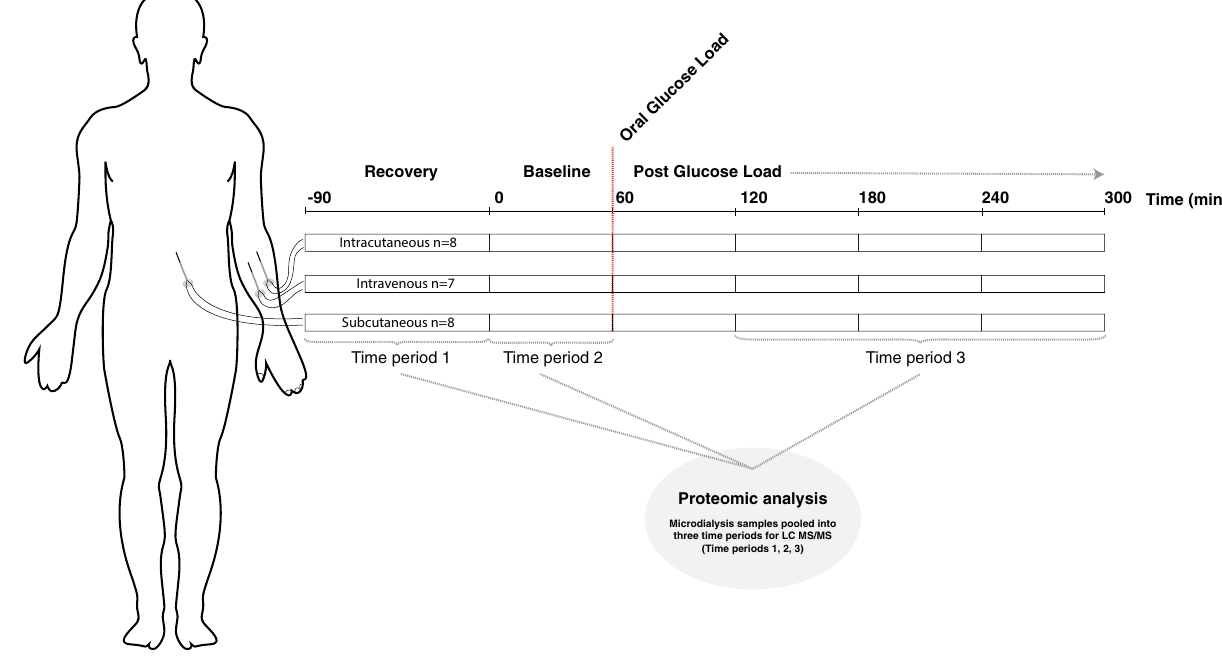
Figure 1. Experimental protocol and setup for in vivo microdialysis experiment in healthy subjects (N = 8). Microdialysate samples were pooled to reflect three time periods: (1) recovery period after catheter